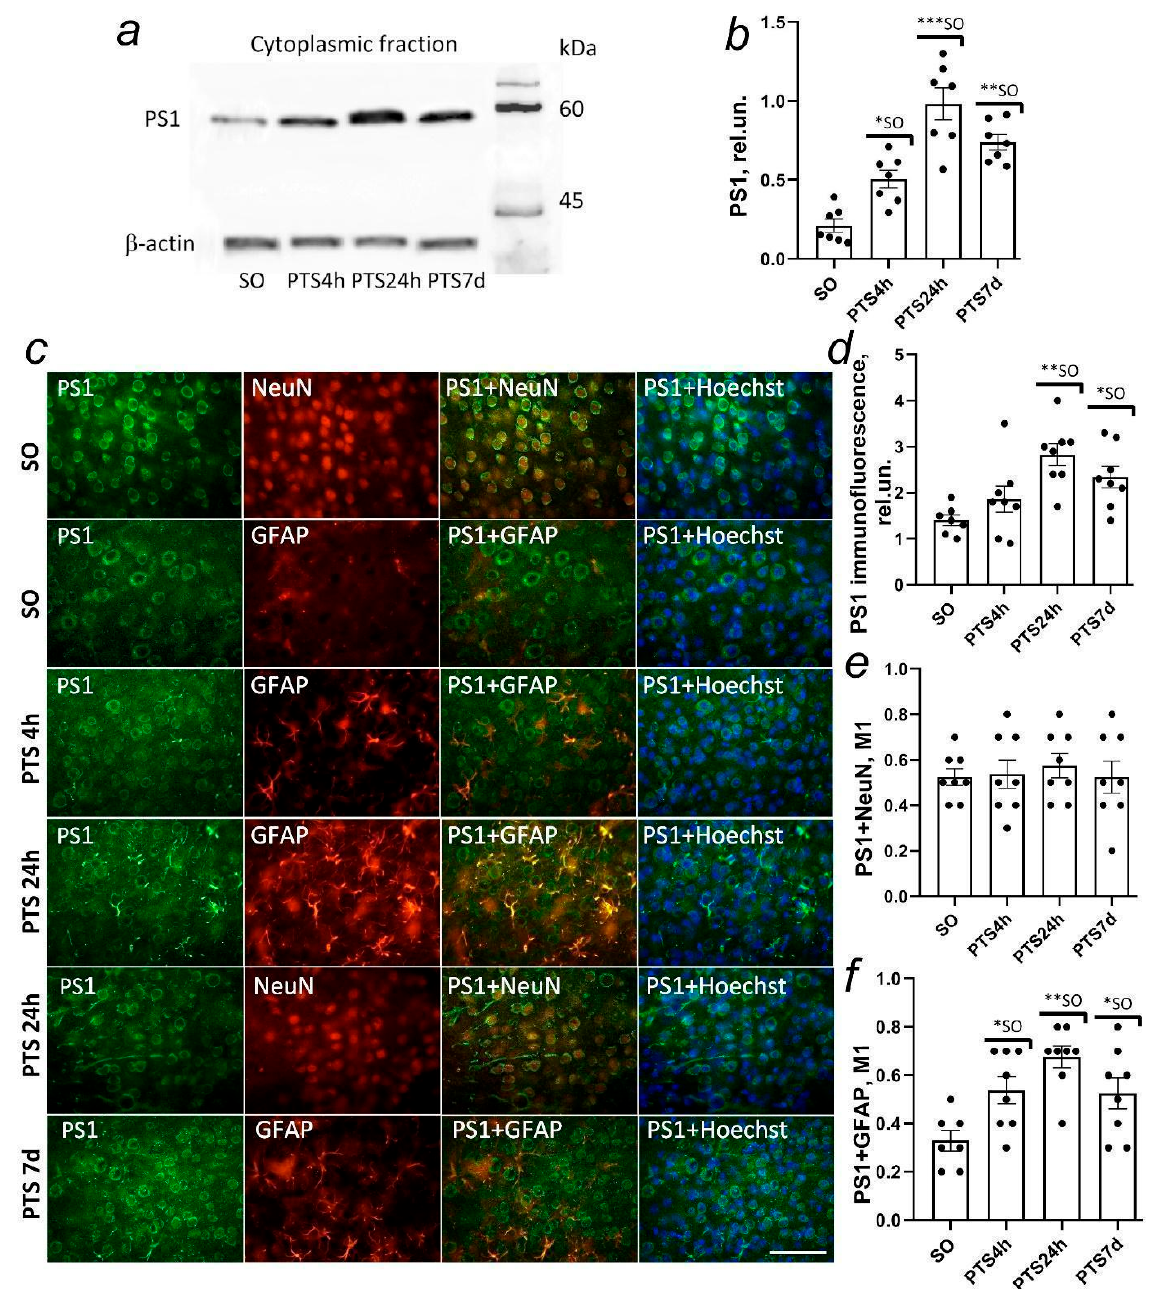
Figure 6. ( a ) Immunoblotting of presenilin-1 (PS1) in the cytoplasmic fraction of the cortex of sham- operated animals (SO) and at 4 h (PTS 4 h), 24 h (PTS 24 h), and 7 days (PTS 7d) after PTS; ( b ) PS1 level in relative units at different timepoints after PTS. The indices of the groups of sham-operated animals at 4 h, 24 h, and 7 days after PTS had no significant differences, therefore the indices of the three groups were combined. ( c ) Changes in PS1 expression in the penumbra at 4 h, 24 h, and 7 days after PTS in the rat cerebral cortex (PTS 4 h, PTS 24 h, and PTS 7 d, respectively) relative to the cortex of sham-operated animals (SO). Immunofluorescence of PS1 (green), GFAP (astrocytes marker, red), and NeuN (neuron marker, red); image overlay of PS1 with GFAP, Neun, and Hoechst 33342 (nuclei marker, blue). Scale bar 100 µ m. ( d ) Changes (in relative units) in PS1 fluorescence in penumbra cells after PTS and in the cortex of sham-operated rats. ( e ) Localization of PS1 in penumbra astrocytes. ( f ) Localization of PS1 in penumbra neurons. One-way ANOVA. M ± SEM. n = 7–8. * p < 0.05 compared to the SO; ** p < 0.01 compared to the SO; *** p < 0.001 compared to the